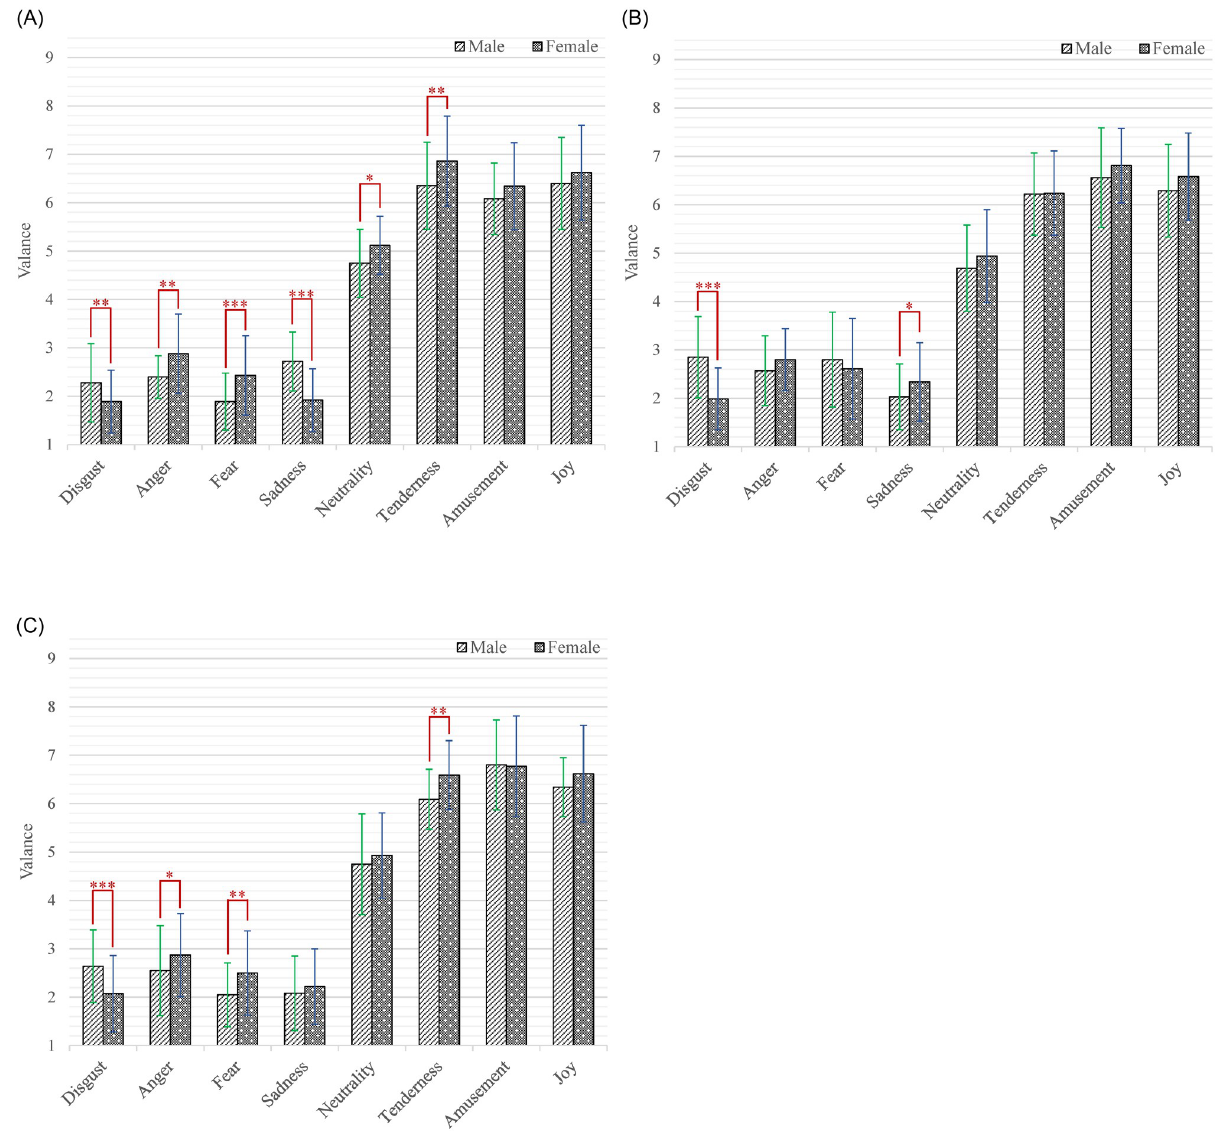
Fig 4. The valence scores of each category of emotion-inducing short videos between male and female. A: Age = 20–24. B: Age = 25–29. C: Age = 30–34. Statistical significance: * p < 0.05, ** p < 0.01, *** p < 0.001. Unless marked with the asterisk, no significant differences between these groups were